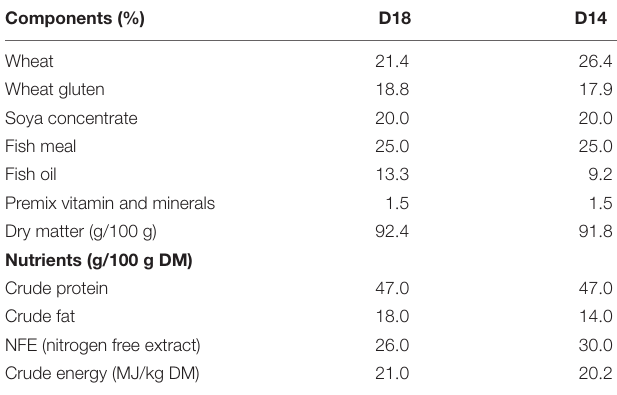
TABLE 1 | Diets formulation and chemical